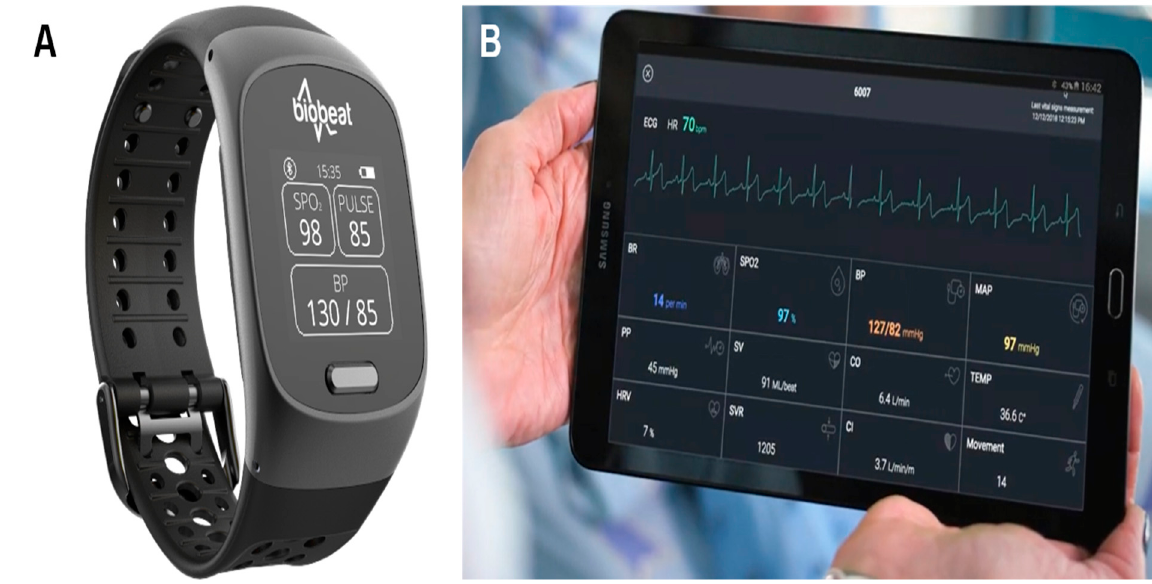
Figure 1. The Biobeat remote patient monitoring platform. ( A )The wristwatch device. ( B )Real-time measurement collected by the device.